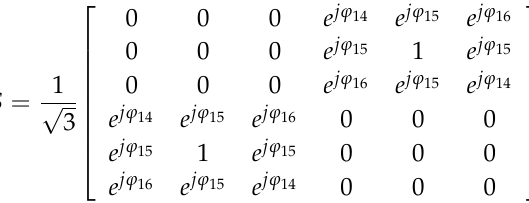
Figure 6. Experimental phase difference between the coupled and direct port of the directional coupler in Figure 4. Figures adapted from [32].